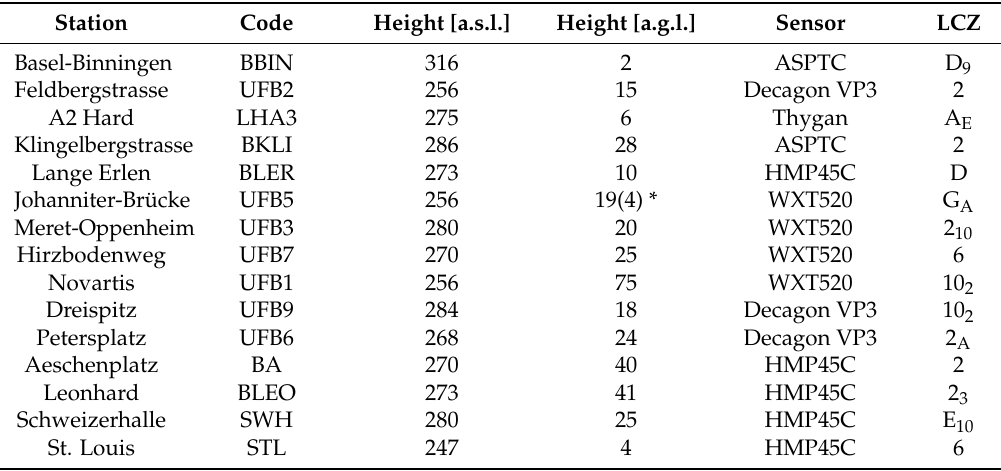
Table 1. List of all stations used for this study with the specific code as an abbreviation. The geographic location of the stations can be found in Figure 1. The local climate zones (LCZ) definition is based on previous work and expert knowledge after the guidance of Stewart and Oke (2012) [44,45]. Station Code Height [a.s.l.] Height